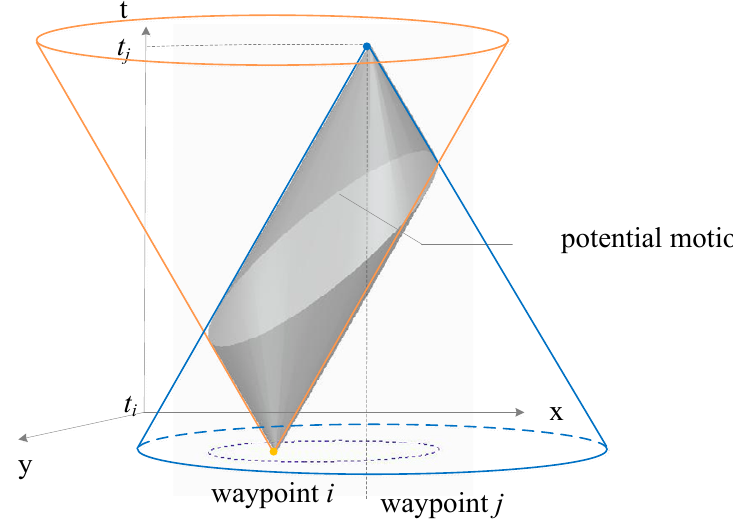
Figure 6. Schematic of spatiotemporal motion space.